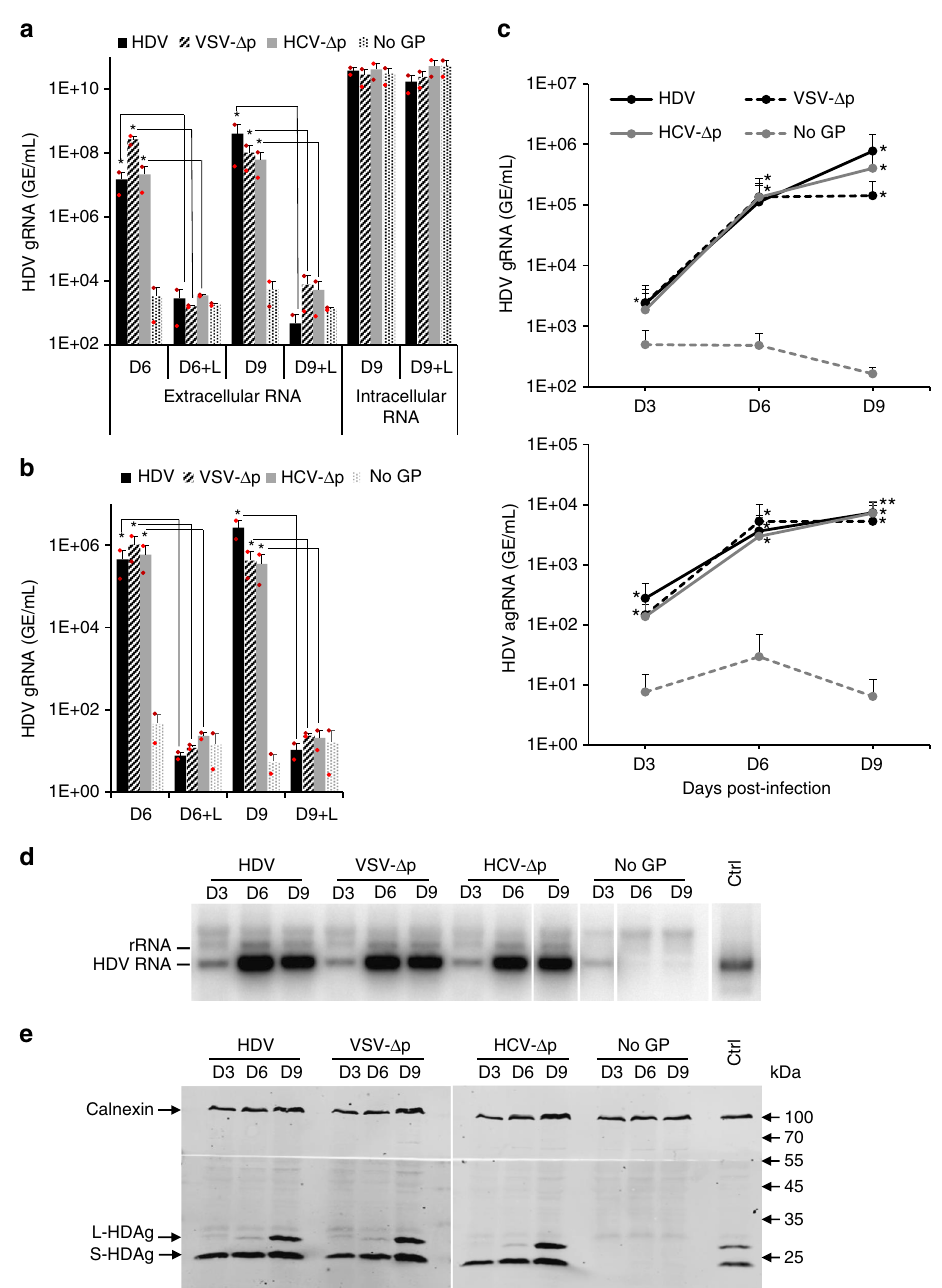
Fig. 3 HDV, VSV- Δ p, and HCV- Δ p particles share an early step of assembly and induce identical HDV markers in infected cells. Huh-7 cells were co- transfected with pSVLD3 plasmid coding for HDV RNPs and plasmids coding for HBV (HDV), VSV (VSV- Δ p), or HCV (HCV- Δ p) envelope glycoproteins. As control, pSVLD3 was transfected without envelope proteins (No GP). a The transfected cells were grown in the presence (or not) of 1 mM Lonafarnib ( + L), a farnesyltransferase inhibitor, until collecting at day 6 or 9 post transfection (D6 vs. D6 + L and D9 vs. D9 + L) the cell supernatants, which were fi ltered and inoculated to Huh-106 cells. The RNAs from producer cells and supernatants were extracted and the HDV genomes (gRNAs) were quanti fi ed by a strand-speci fi c RT-qPCR assay. The quanti fi cation of intracellular HDV RNAs in cells producing the HDV particles at day 9 post transfection is also shown. HDV RNA levels in GE (genome equivalent) are expressed as means ( n = 2 independent experiments) per ml of cell supernatants for extracellular RNAs or, for intracellular RNAs, per ml of cell lysates containing 10 6 cells. b The inoculated cells were grown for 7 days before total intracellular RNA was puri fi ed. The results of HDV gRNA quanti fi cation by RT-qPCR are expressed as means ( n = 2 independent experiments) per ml of cell lysates containing 10 6 cells. c – e Huh-106 cells inoculated with the indicated viral particles were harvested at different time points post infection. The RNAs were then extracted from the lysed cells. The HDV RNAs were quanti fi ed by genomic (gRNA) (upper panel) or antigenomic (agRNA) (lower panel) strand-speci fi c RT-qPCR assays and are expressed as means ( n = 4 independent experiments) GE per ml of cell lysates containing 10 6 cells ( c ). The results of a northern blot experiment using 3 µ g of total cellular RNA per well that were revealed with a HDV-speci fi c probe ( d ). Intracellular proteins were extracted and analyzed by western blot using an HDAg antibody ( e ). Control HDV RNAs (5 × 10 7 GE) ( d ) or HDAg from cell lysates ( e ) were loaded on the same gels (Ctrl). Source data are provided as a Source Data fi le. Error bars correspond to standard deviation. Statistical analyses (Student ’ s t- test): p < 0.05 (*); p < 0.01